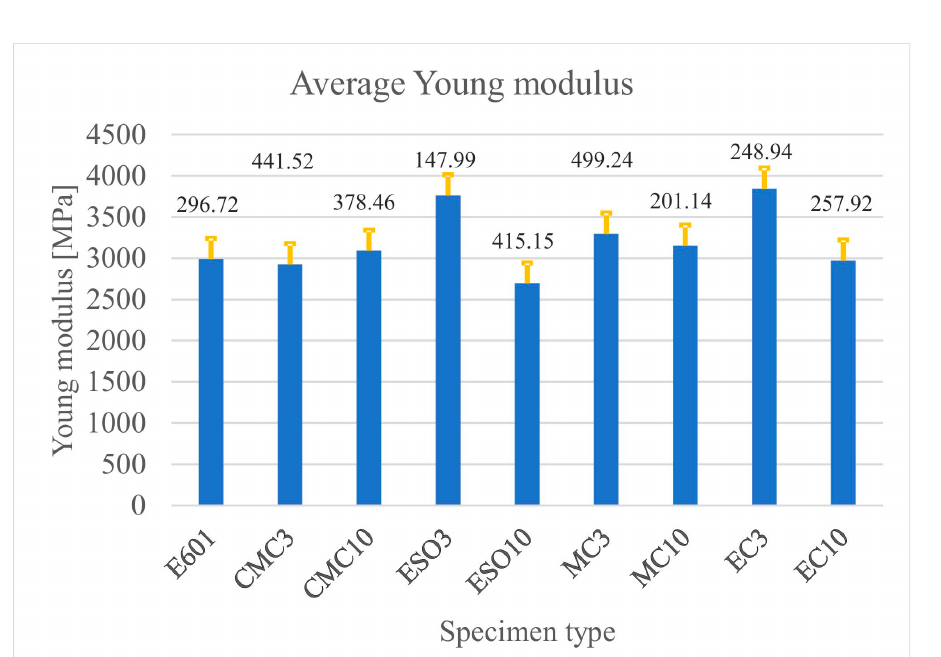
Figure 7. Average values of Young’s modulus with standard deviation bars as a function of the specimen type.